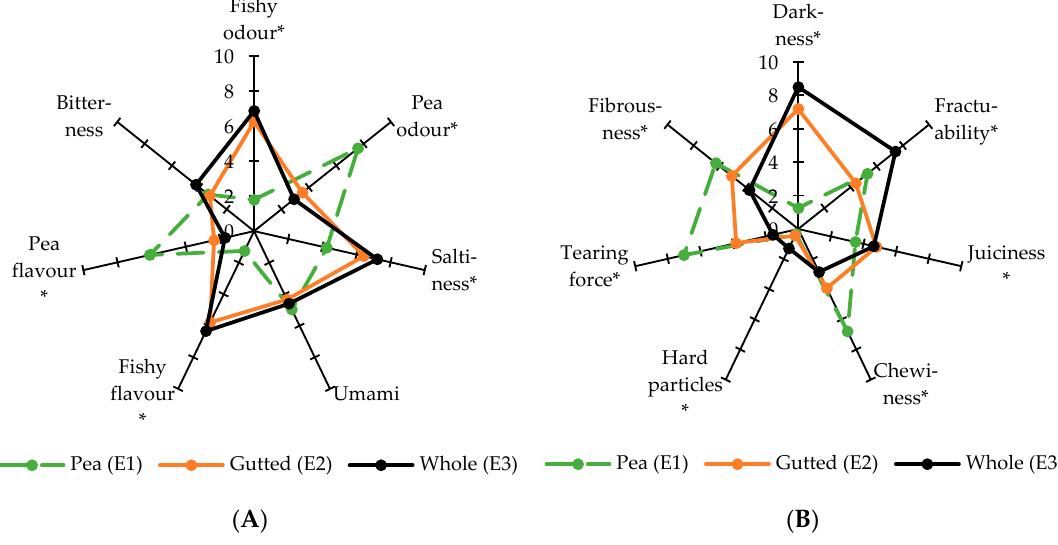
Figure 3. Descriptive sensory profiles of the extrudates: ( A ) the taste ‐ and odour ‐ related profiles, ( B ) the structure and appearance related profiles. The attributes marked with an asterisk (*) have statistically significant differences between samples ( p < 0.05 in the two ‐ way mixed model analysis of variance (ANOVA)).